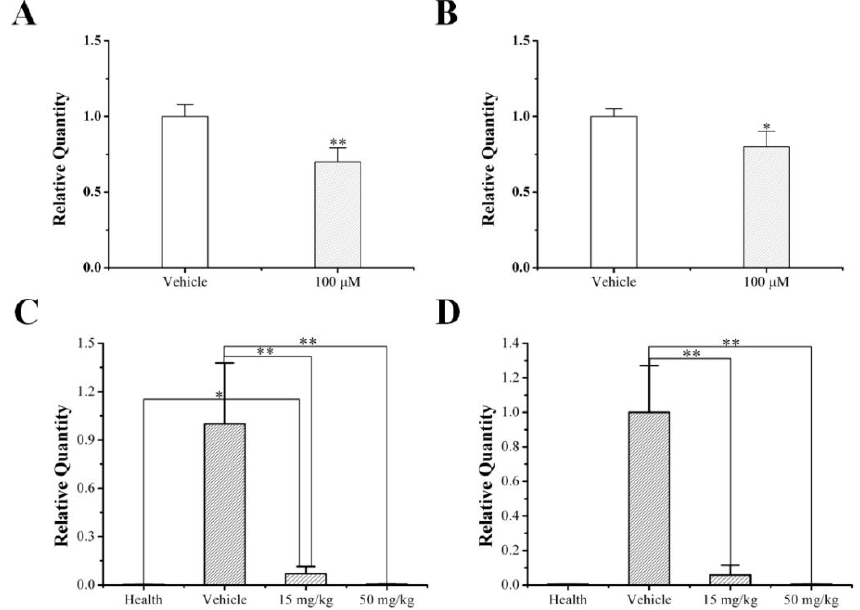
Figure 5. Foretinib reduced the mRNA expression of MET ( A , C ) and HGF ( B , D ) in MDA-MB-231 cells and xenograft tumors. The expression of GAPDH was included as a loading control. *, p < 0.05; **, p < 0.01, compared with the vehicle control.